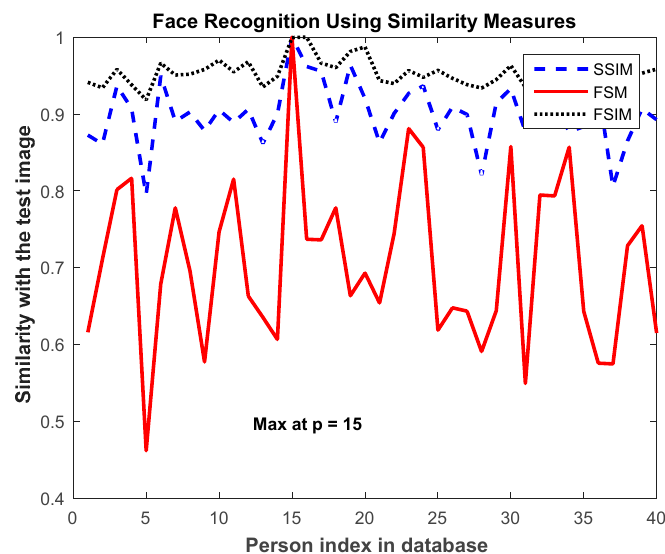
Figure 11. Performance of similarity measures using person No. 15 in the FEI database. Pose 8 is the Reference Image, while pose 10 is used for testing for all database images (including the target person). FSIM fails, while confidence in recognition for SSIM, and FSM is 0.0364, 0.12 respectively.